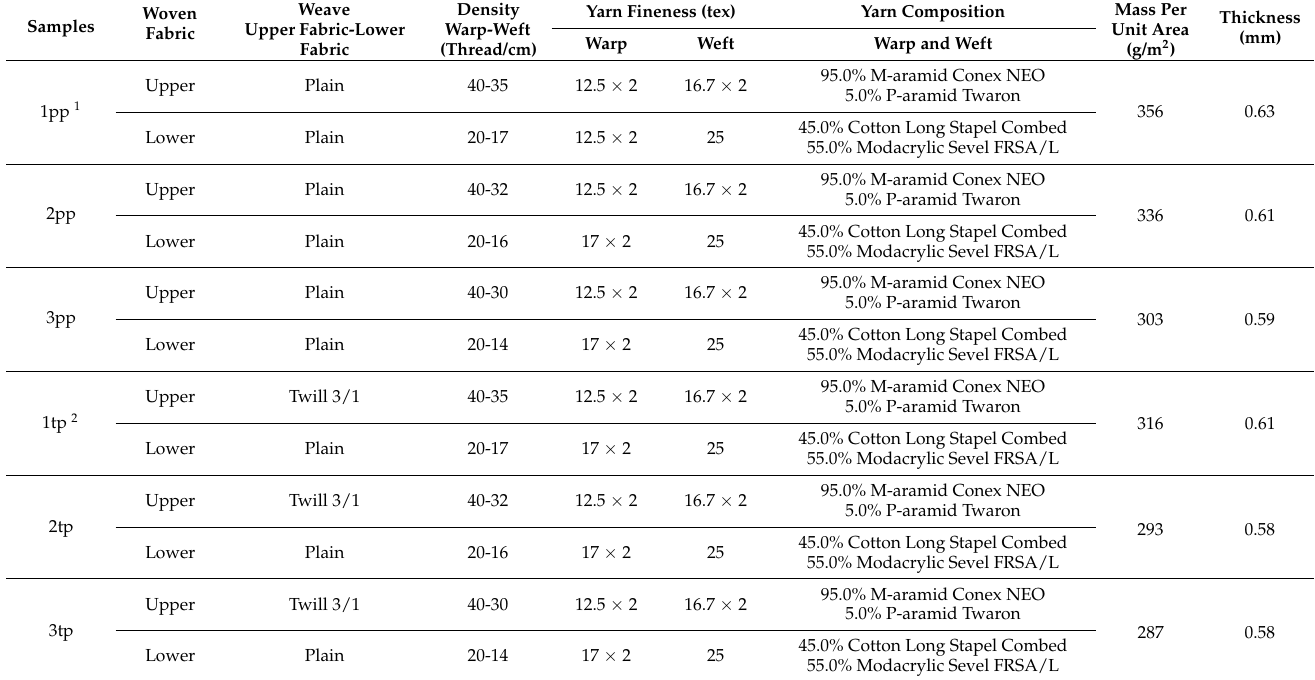
Table 1. Basic parameters of the 3D-woven